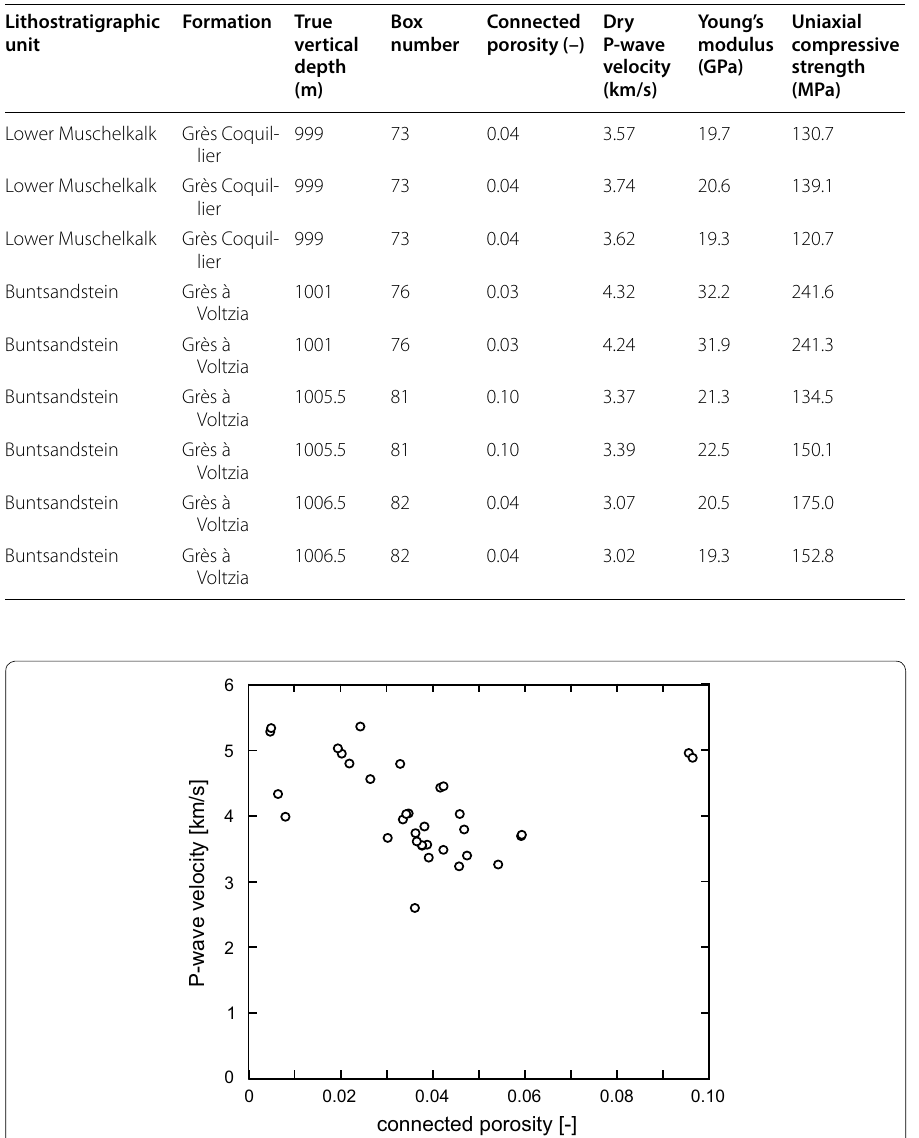
Fig. 6 Dry P-wave velocity (measured at ambient pressure and temperature) as a function of connected porosity for Muschelkalk samples from exploration well EPS-1